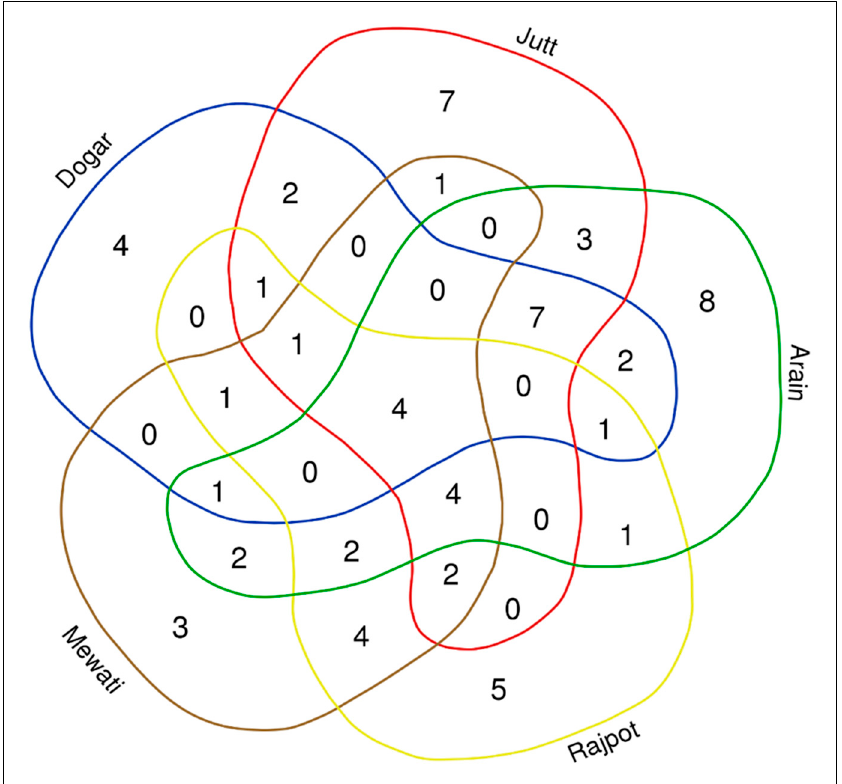
Figure 6. Venn diagram depicting the overlap of quoted wild edible plants among the five studied ethnic groups.